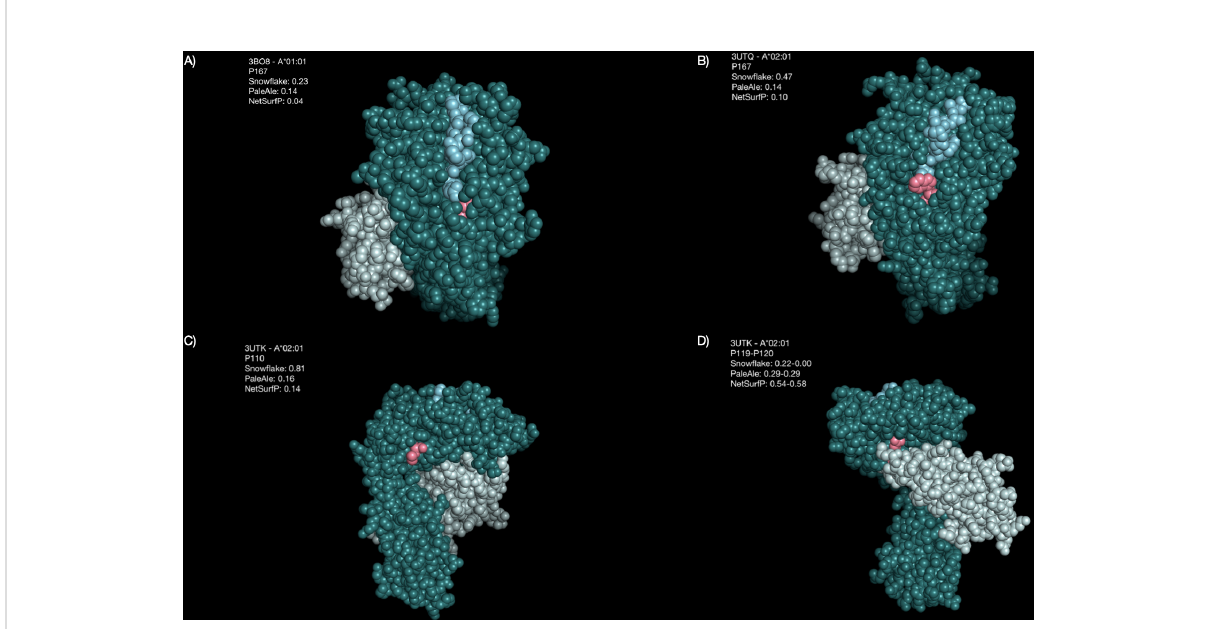
FIGURE 9 Highlighted amino acid positions of selected structures. The HLA alpha chain is colored in dark green, beta-2-microglobulin is colored in light green, the bound peptide is colored in blue, and the highlighted amino acid positions are colored pink. (A) Position P167 is predicted by Snow fl ake and the reference predictors to be buried in A*01:01. (B) The same position P167 in A*02:01 is predicted by Snow fl ake to be accessible, by the reference predictors again predicted to be buried. (C) The reference predictors estimate position P110 in A*02:01 to be buried, whilst Snow fl ake considers it accessible. (D) For A*02:01, positions P119 and P120 are contact points with the beta-2-microglobulin. Whilst Snow fl ake considers these positions not being accessible, NetSurfP considers them as